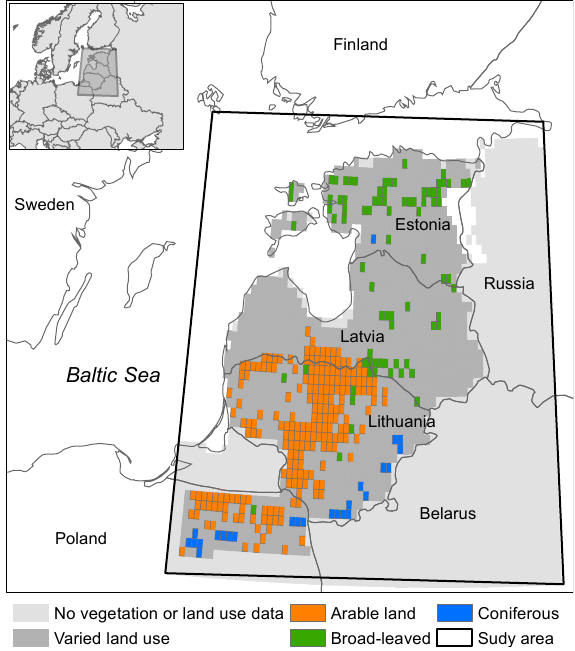
Figure 1. Study area in the eastern part of the Baltic Sea region. The dominant type of land use in 0.144 ◦ × 0.144 ◦ cells was estimated according to the CORINE land use